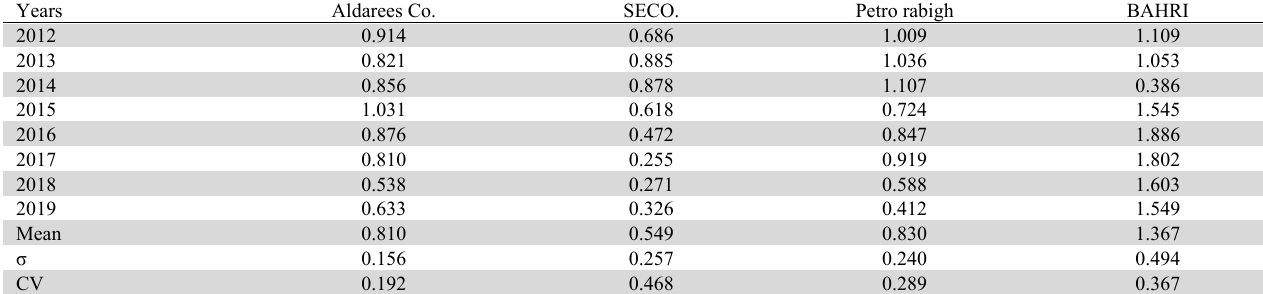
Short-term paying ability (Current Ratio) of the energy sector companies of Saudi Arabia Years Aldarees